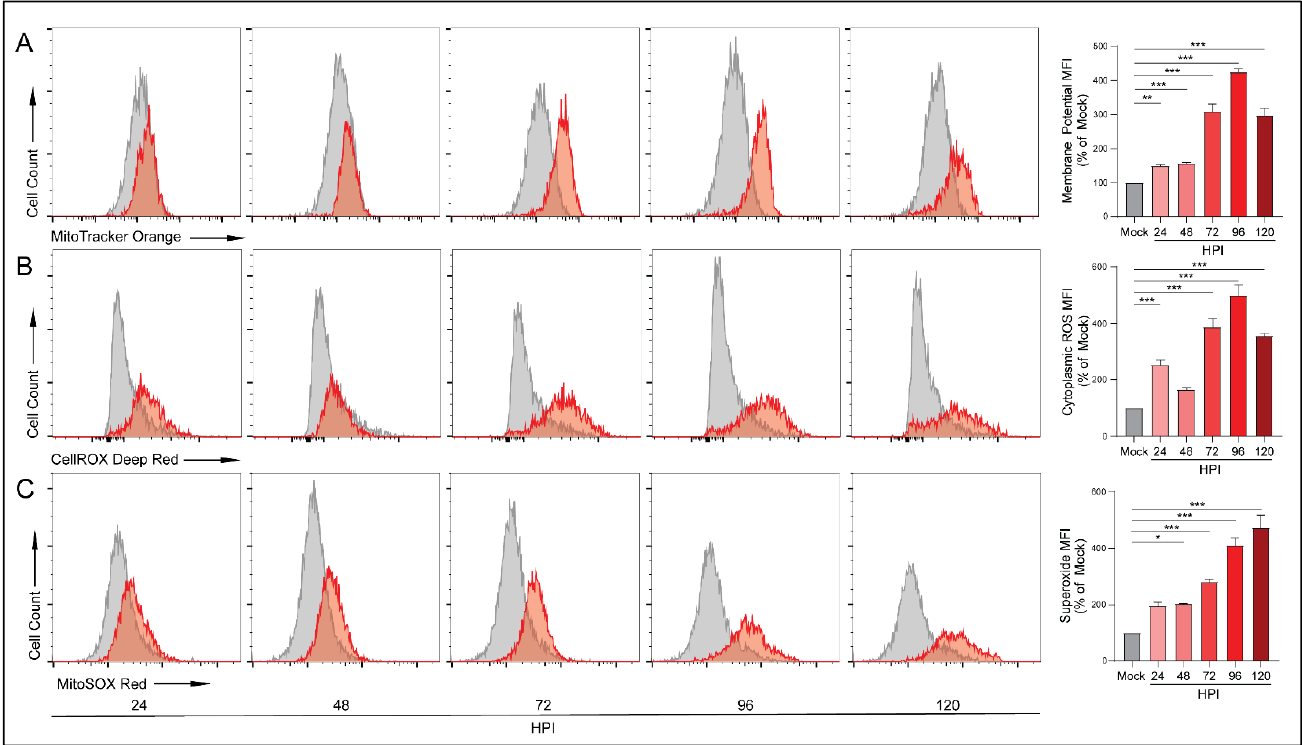
Figure 4. HCMV infection increases electron transport chain function. Flow cytometry was used to quantify functional aspects of the electron transport chain. ( A ) Mitochondrial membrane potential was analyzed in mock- or HCMV-infected LN-18 cells using the reduced rosamine-dye, MitoTracker Orange which is dependent on mitochondrial oxidation to become fluorescent ( B ) cytoplasmic ROS production was detected by CellROX Deep Red, and ( C ) mitochondrial superoxide levels were measured using MitoSOX Red. All samples were gated on singlets and live cells only. Graphs represent pooled data from three independent experiments. Mean ± the SEM of at least 3 triplicates. *, p < 0.05; **, p < 0.01; ***, p < 0.001.